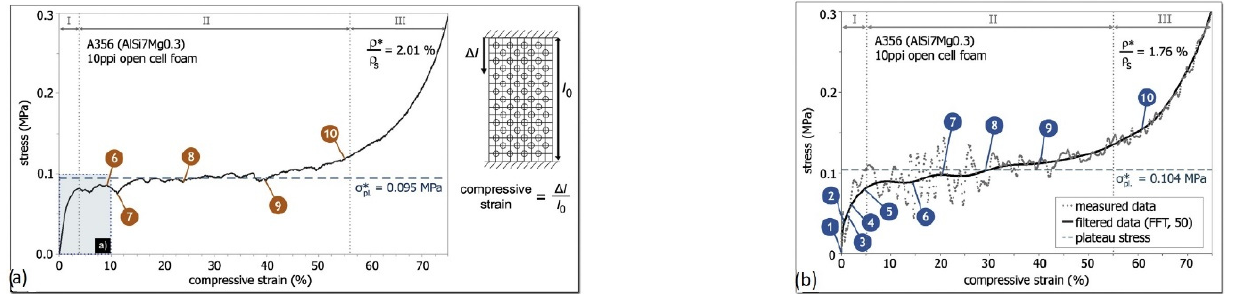
Figure 1. ( a ) σ - ε curve for static load. ( b ) σ - ε curve for dynamic load (1000 mm/s speed) in an Al-Si truncated octahedron structure [4].